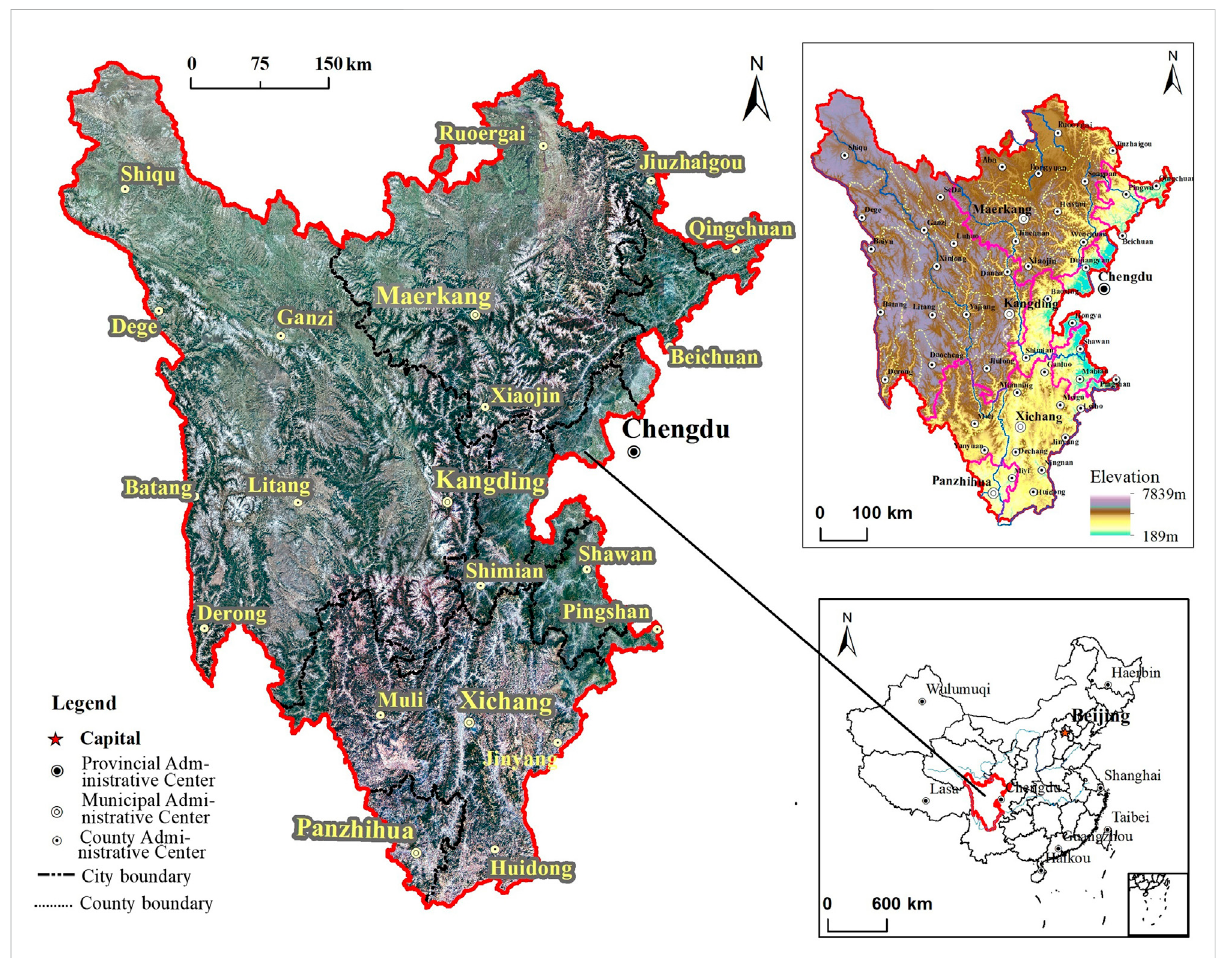
FIGURE 1 Location of the study